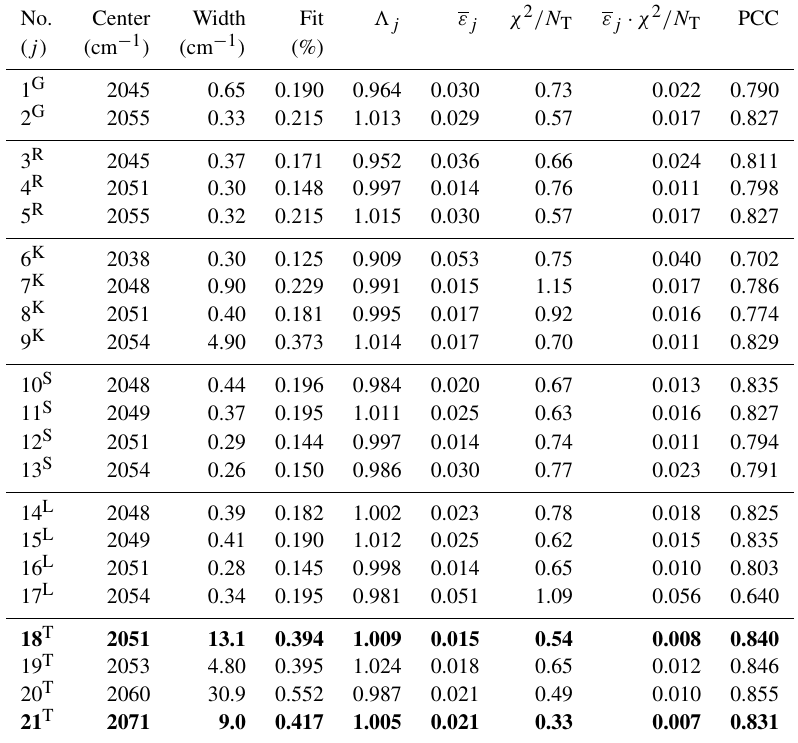
Table B2. Statistical properties of the OCS retrievals from the 21 investigated windows. Center and Width are as in Table B1. Fit is the average RMS spectral fitting residual achieved in that particular window. Of course, this depends on the spectra that are fitted (their altitude, SZA, spectral resolution, etc.), and so its absolute value is somewhat arbitrary, but its window-to-window variation is significant since all windows were fitted in all spectra. (cid:51) j is the average value of the OCS VMR scale factor retrieved from window j , relative to the mean of all windows. ε j is an estimate of the mean uncertainty associated with retrieving OCS from window j , based on the spectral fits. X 2 /N T represents the average value of the ratio of the scatter of the measurements from the mean to the estimated uncertainty. ε j · χ 2 /N T represents the precision of the measurements. The column labeled PCC contains Pearson correlation coefficients of xOCS variations between each evaluated ground-based window and the mean of all windows. Based on these diagnostics, OCS columns retrieved from window nos. 18 and 21 were selected and averaged for subsequent analysis, with the other 19 windows